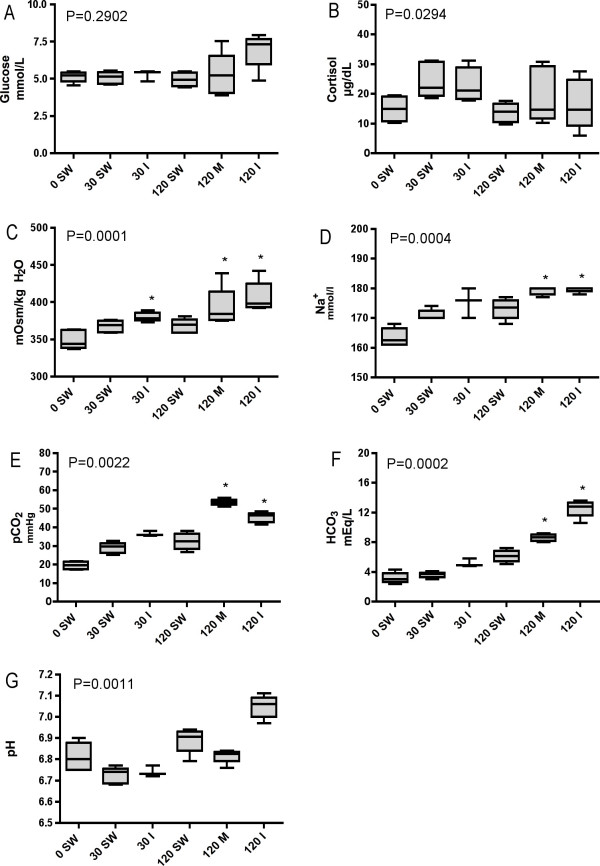
Blood and plasma parameters analyzed in the six different fish groups. Group identity: 0 min. seawater control (0 SW), 30 min. seawater (30 SW), 30 min. isoeugenol (30 I), 120 min. seawater (120 SW), 120 min. metacaine (120 M) and 120 min. isoeugenol (120 I). A) glucose, B) cortisol, C) osmolality, D) Na+, E) pCO2, F) HCO3 and G) pH. For cortisol (C) and osmolality measurements (D), n = 6 in all groups except 120 min. metacaine and 120 min. isoeugenol groups (n = 5). For the I-Stat measurements (A, D, E, F, and G), n = 6 in the 0 min. control group, n = 5 in the 30 min. group, n = 3 in the 30 min. isoeugenol group, n = 4 in the 120 min. and the 120 min. metacaine group and n = 5 in the 120 min. isoeugenol group. The horizontal line in the middle of the box plot show the median (50% percentile) of the sample. The top and bottom of the box show the 75th and 25th percentiles, respectively, whereas the top and bottom of the whiskers show the maximum and minimum values. An * denotes significant differences (P < 0.05) between the 0 min. control group and the other groups (Kruskal Wallis ANOVA).